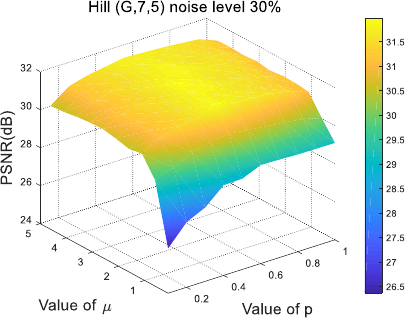
Figure 5. E ff ect of the p and µ values on PSNR: PSNR (dB) for the recovery of image “Hill” degraded Figure 5. Effect of the p and  values on PSNR: PSNR (dB) for the recovery of image “Hill” degraded with a Gaussian blur kernel ( G ,7,5 ) and 30% impulse with a Gaussian blur kernel ( ,7,5) G and 30% impulse noise.